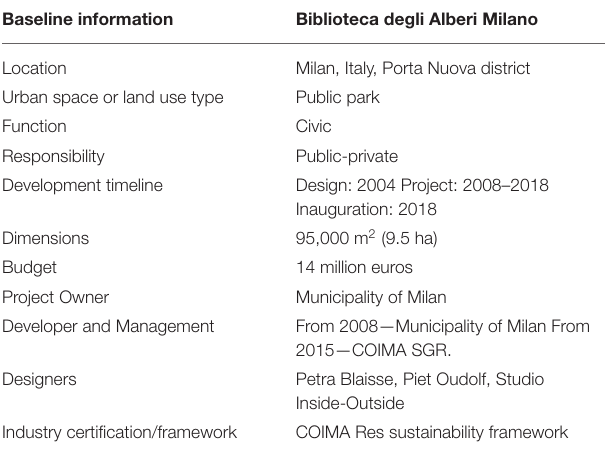
TABLE 3 | Baseline characteristics of